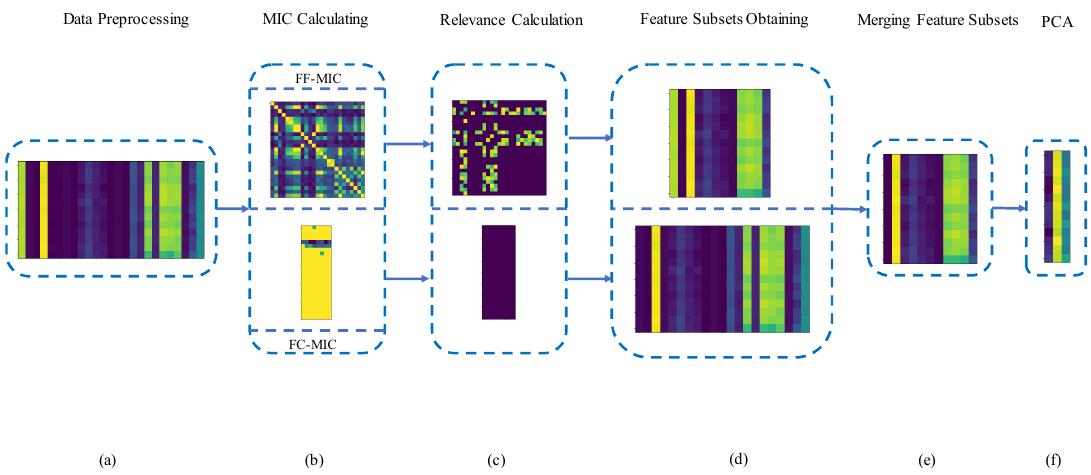
Figure 1. Flowchart of the proposed method. ( a ) Data preprocessing: Features are obtained through the time domain and frequency domain, forming a feature set ( FS ) matrix with a size of n × m ; ( b ) MIC (Maximum Information Coefficient) calculation: relevance between features and features are calculated to obtain an FF-MIC matrix with a size of m × m by MIC, and relevance between features and fault categories are calculated to obtain the FC-MIC matrix with a size of m × p by MIC; ( c ) relevance calculation: a threshold FF _ threshold is set to distinguish strong irrelevance features from FS , and a threshold FC _ threshold is set to distinguish strong relevance features from FS ; ( d ) obtaining of feature subsets: according to the thresholds, Subset1 and Subset2 are obtained; ( e ) merging of feature subsets: An intersection operation is applied to merge Subset1 and Subset2, obtaining a final subset F − Subset ; ( f ) PCA: PCA is employed to further reduce the dimension of F − Subset .